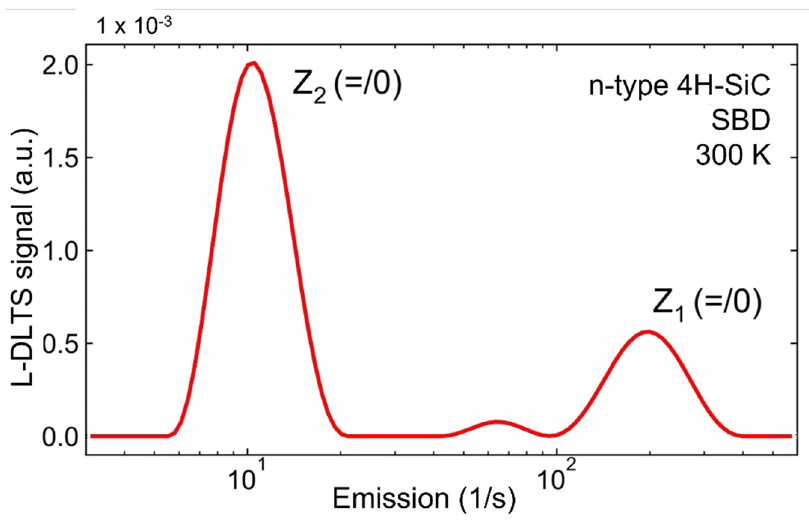
Figure 5. Laplace DLTS (L-DLTS) spectrum for the as grown n-type 4H-SiC SBD measured at room temperature (RT)